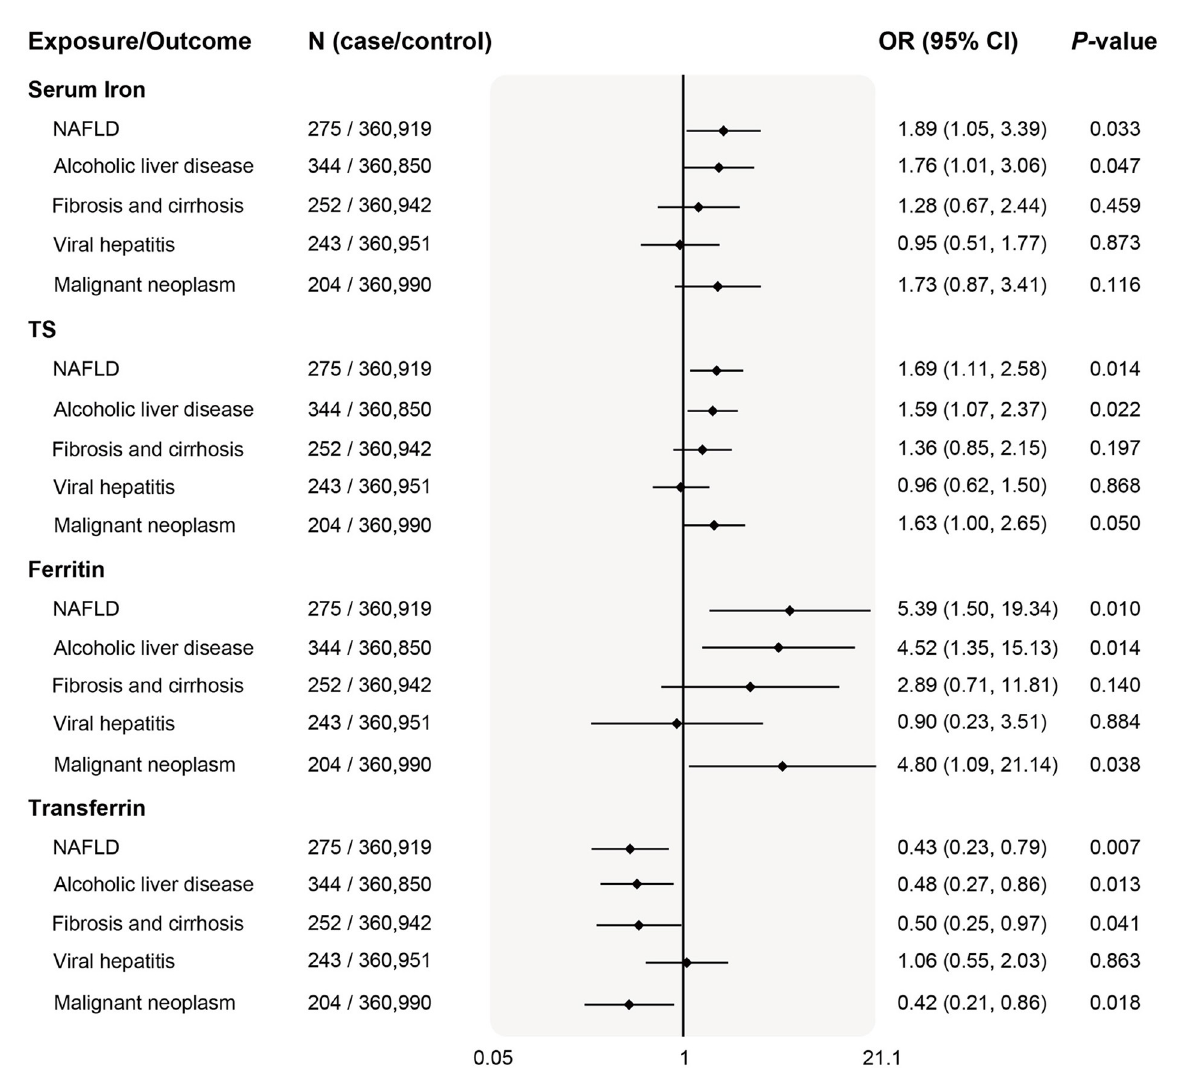
FIGURE3 Associations of genetically predicted iron status and liver diseases. The OR (95% CI) of liver diseases (NAFLD, ALD, fibrosis and cirrhosis, viral hepatitis, and malignant neoplasm) per SD increase of iron status biomarkers were estimated using fixed-effect inverse-variance weighted meta-analysis. OR, odds ratio; 95% CI, 95% confidence interval; NAFLD, nonalcoholic fatty liver disease; ALD, alcoholic liver disease; SD, standard deviation.